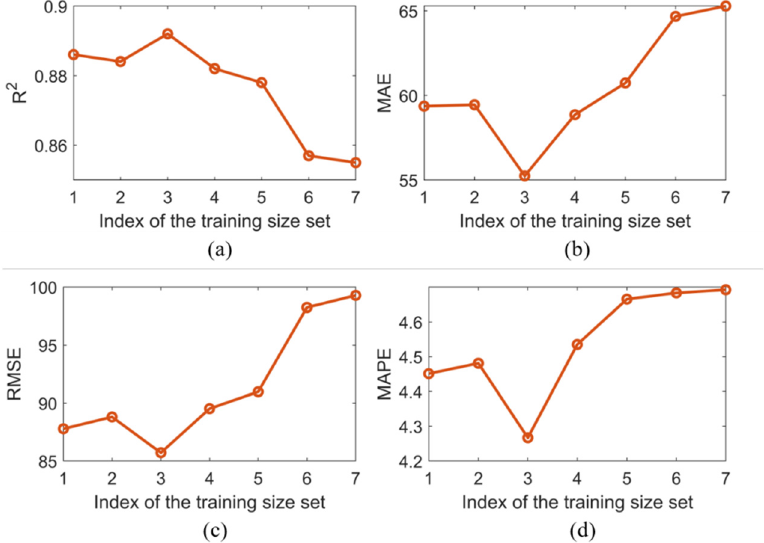
Figure 10. Sensitivity analysis on training size. ( a ) R2. ( b ) MAE. ( c ) RMSE. ( d ) MAPE.